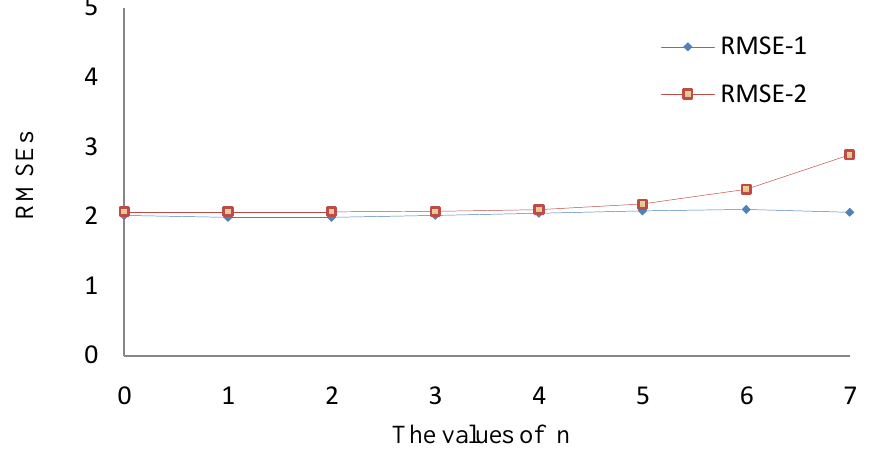
Figure 2. Empirical studies on parameter sensitivity.